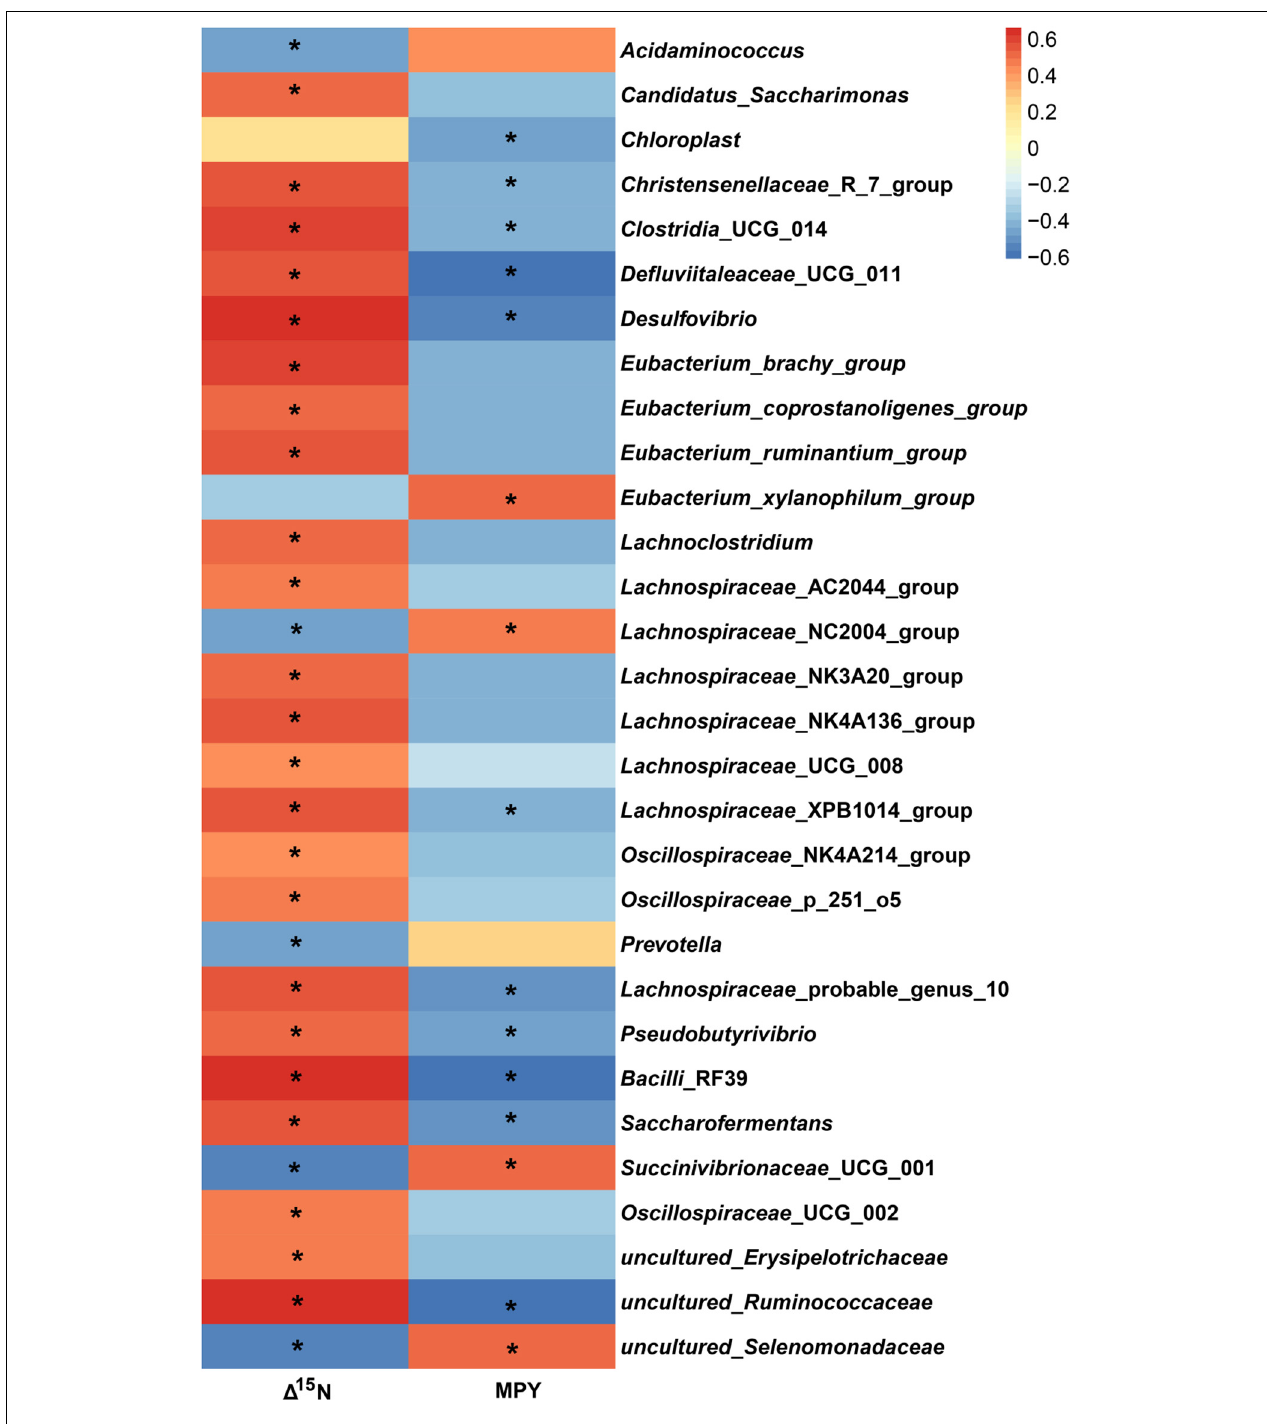
FIGURE 6 | Spearman correlations between specific bacterial genera, (cid:49) 15 N, and MPY. The asterisk means significant difference ( P <